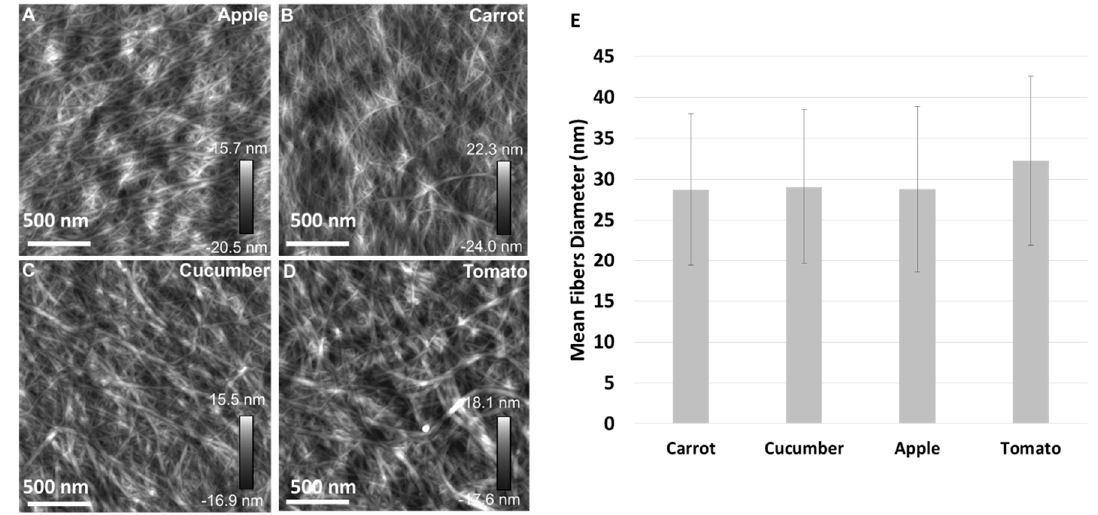
Figure 3. Representative atomic force microscope (AFM) height images of cellulose isolated from apple ( A ), carrot ( B ), cucumber ( C ), and tomato ( D ) pomaces and mean microfibril diameters of individual samples ( E ).